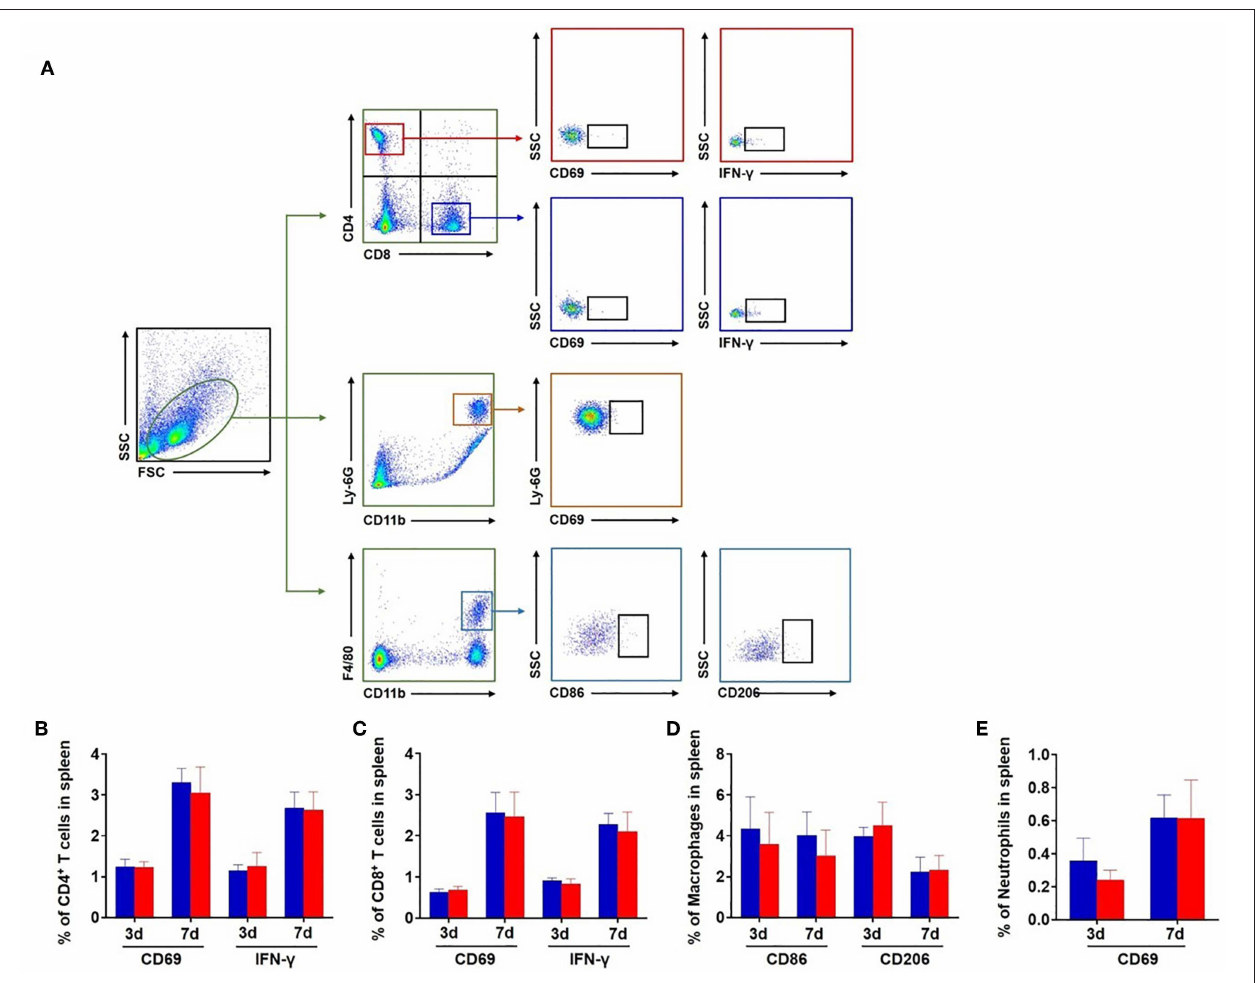
FIGURE 6 | Expression of CD69 and IFN- γ in splenic leucocytes of db/db and db/ + mice after brain ischemia. (A) Gating strategy of CD4 + T, CD8 + T cells, and neutrophils expressing CD69 and IFN- γ and macrophages expressing CD86 and CD206 in the spleen after dMCAO. The counts of CD4 + T (B) , CD8 + T cells (C) , and neutrophils (D) expressing CD69 and IFN- γ in the spleen of db/ + and db/db mice at 3 and 7 days after ischemia. The counts of macrophages (E) expressing CD86 and CD206 in the spleen of db/ + and db/db mice at 3 and 7 days after ischemia. Mean ± s.e.m. n = 8 per group.